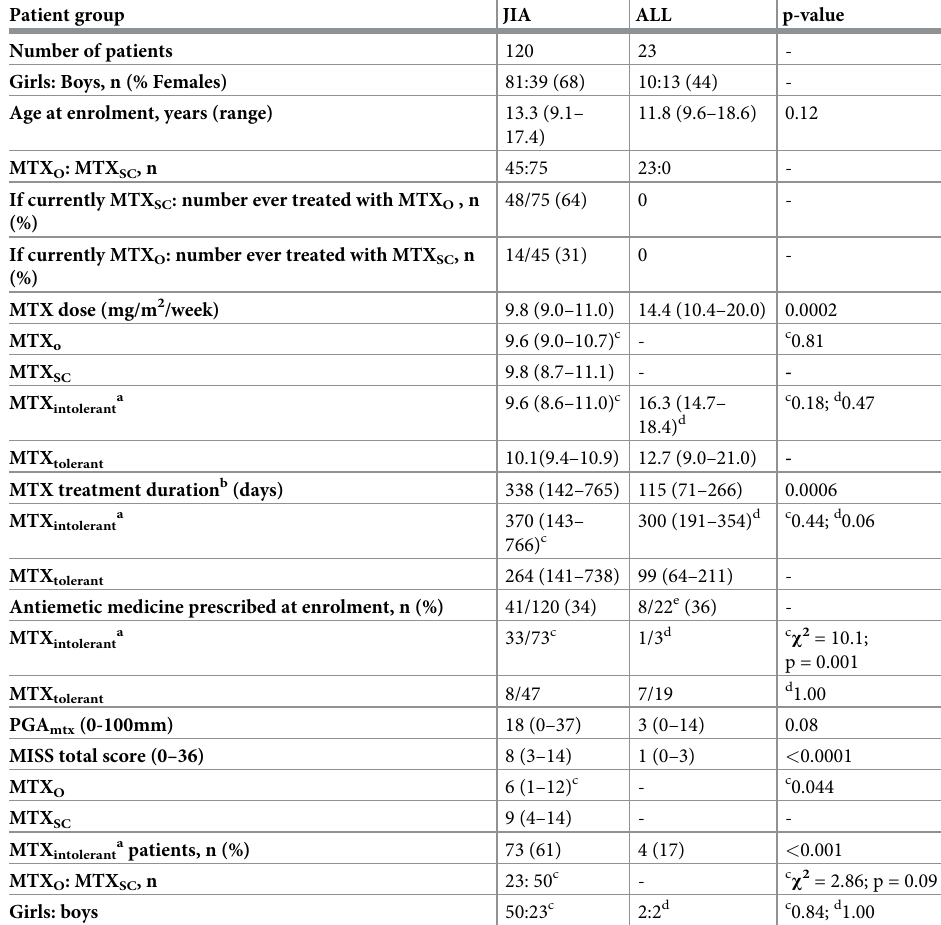
Table 1. Demographics and methotrexate intolerance. Patient group JIA ALL Number of